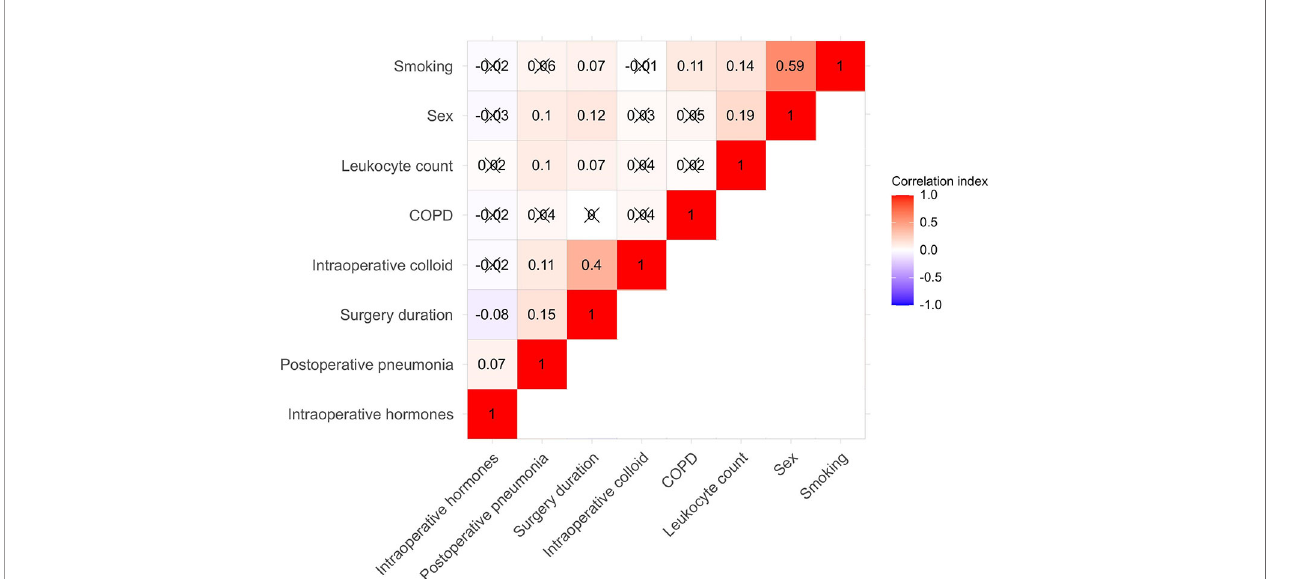
FIGURE 2 | Heat map for the seven algorithm-included variables and postoperative pneumonia. Correlation matrix was shown and the Pearson correlation was given in each small square. Red represents positive correlation, white represents no correlation, and blue represents negative correlation. COPD indicates chronic obstructive pulmonary disease.